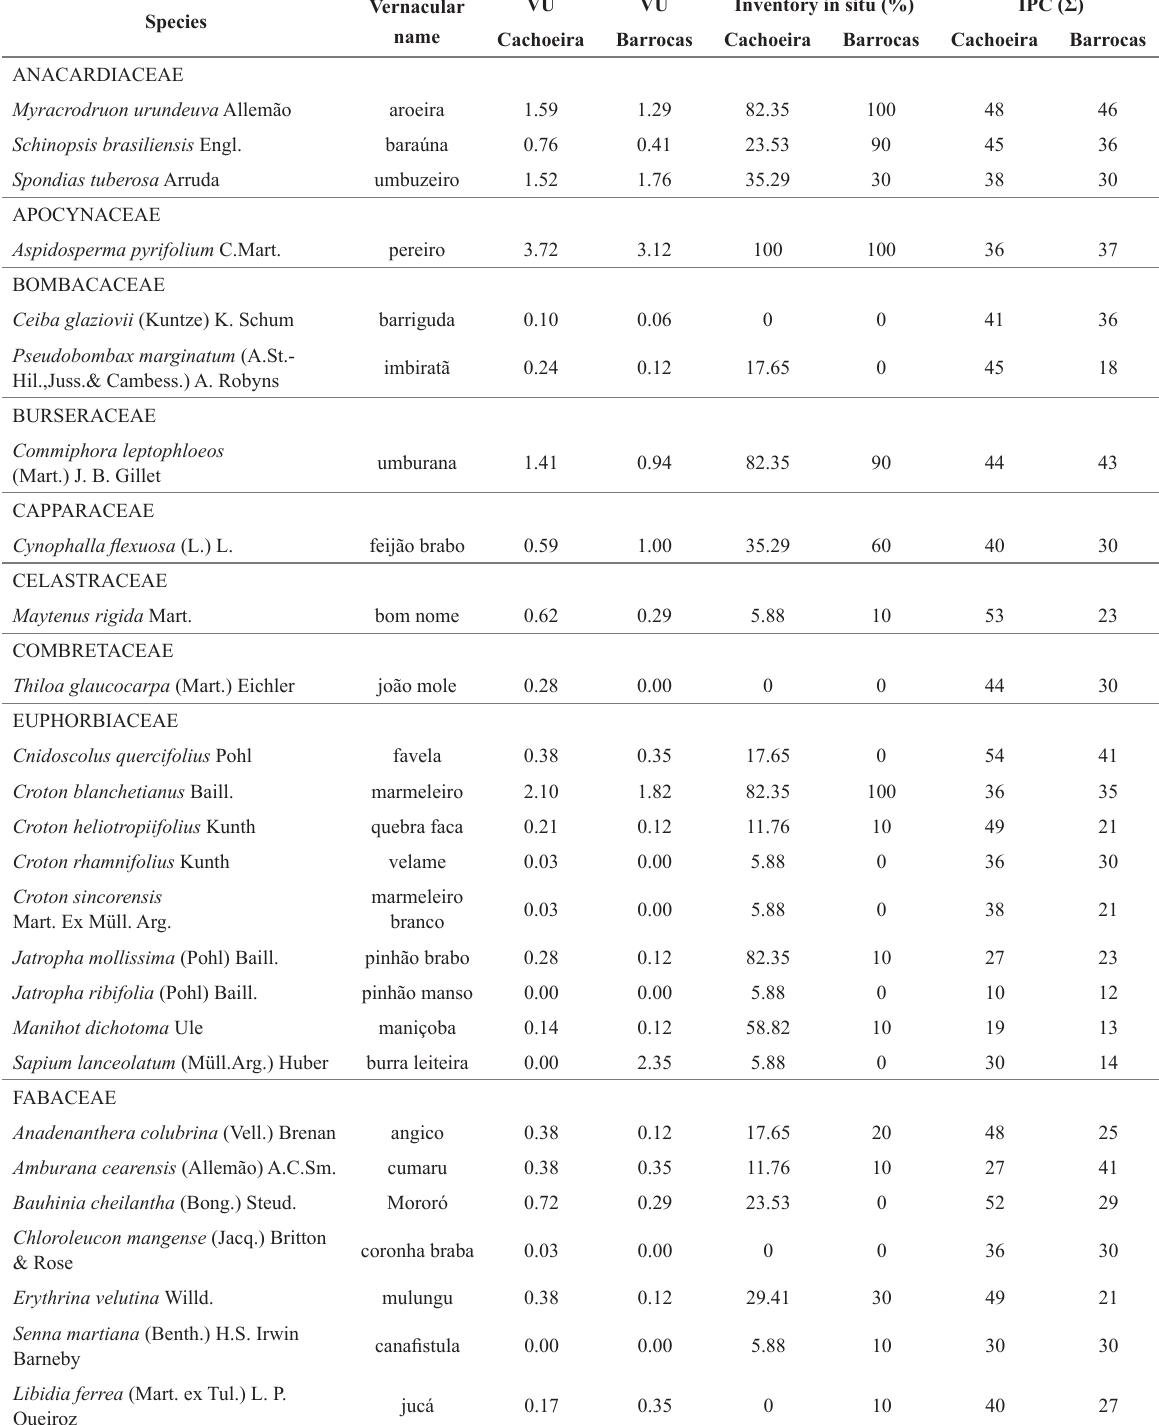
Ranking of species of greater local importance, second highest use value (VU), the frequency in inventory in situ and conservation priority index (IPC) in the communities of Barrocas and Cachoeira in the municipality of Soledade, Northeast